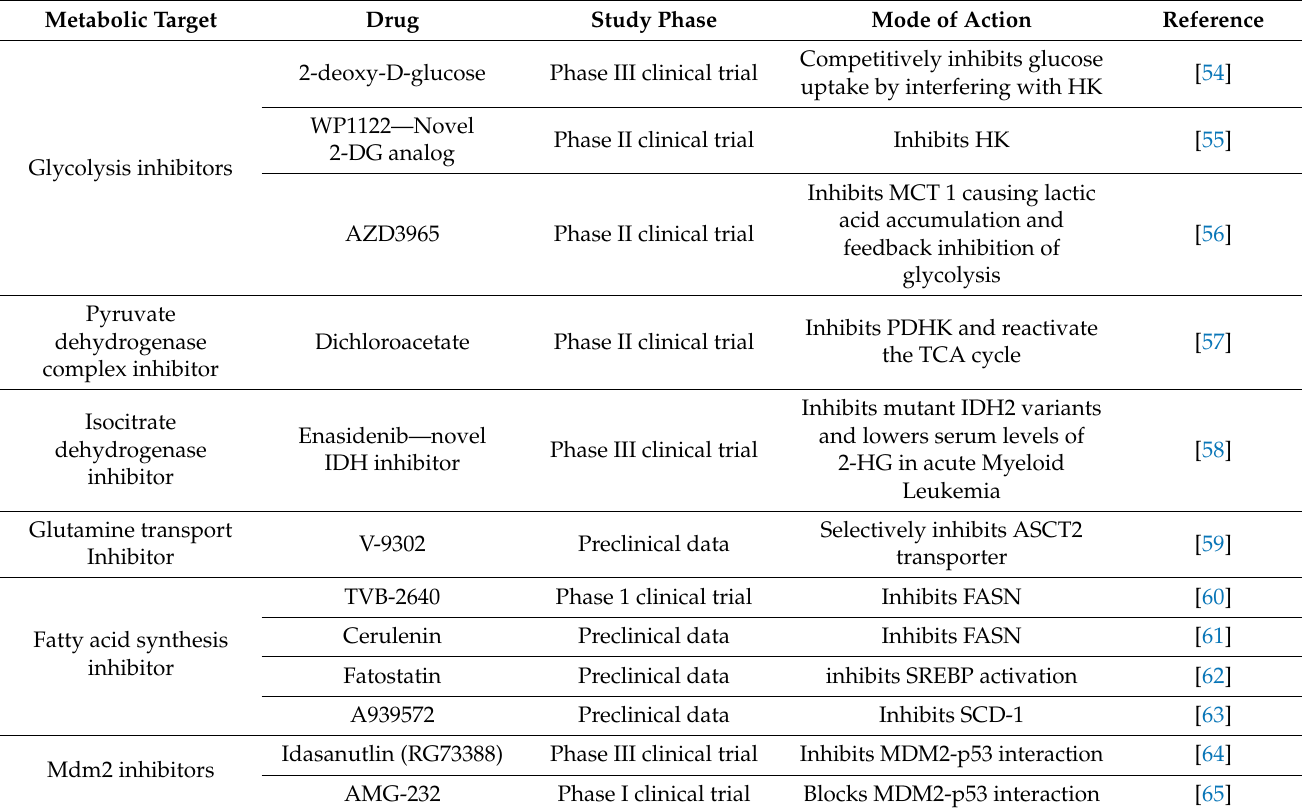
Table 2. Pharmacological agents targeting cancer metabolic